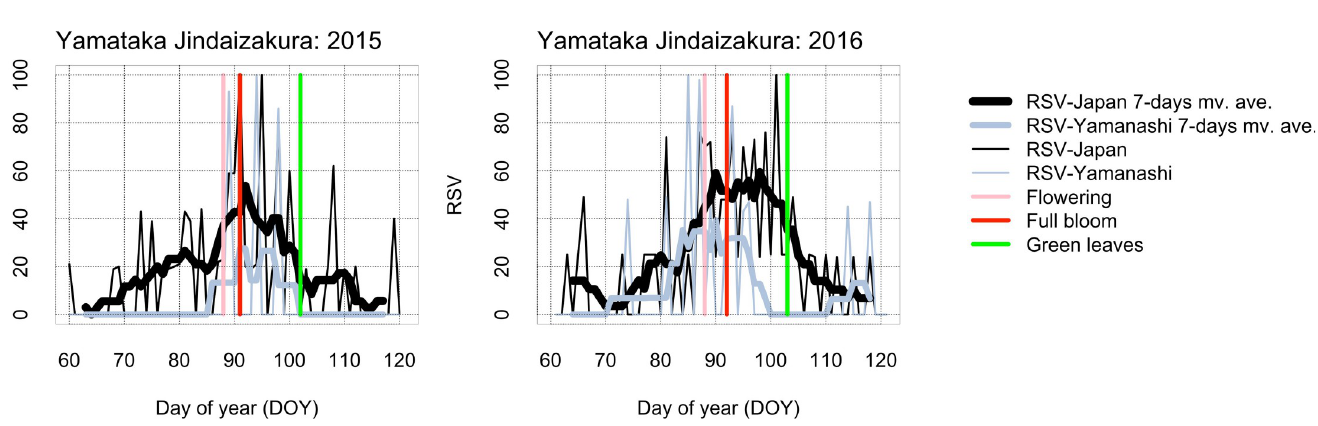
Fig 4. For Yamataka Jindaizakura, the relationship between time-series of RSV searched by “Topics” in all Japan and Yamanashi and flowering information published on websites from 2015 to 2016. For more result regarding the relationship from 2004 to 2014, see S2 Fig. mv. ave.: moving average.